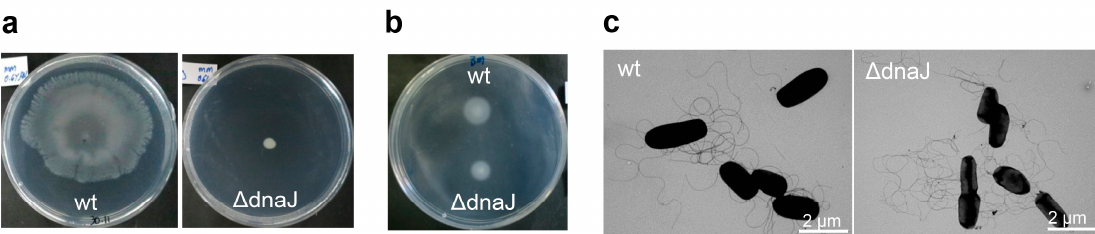
Figure 4. Swarming, swimming, and flagella production in the wild-type strain GR4 (wt) and its dnaJ deletion derivative mutant ( ∆ dnaJ). ( a ) Surface motility assays on semisolid MM (0.6 %). Representative pictures of the motility exhibited by each strain after 48 h of incubation at 28 ◦ C are shown. ( b ) Swimming motility assay in BM (0.3%). Pictures were taken 72 h after inoculation. ( c ) Transmission electron microscopy images showing flagella production of wild-type and dnaJ mutant cells. Scale bars are indicated.